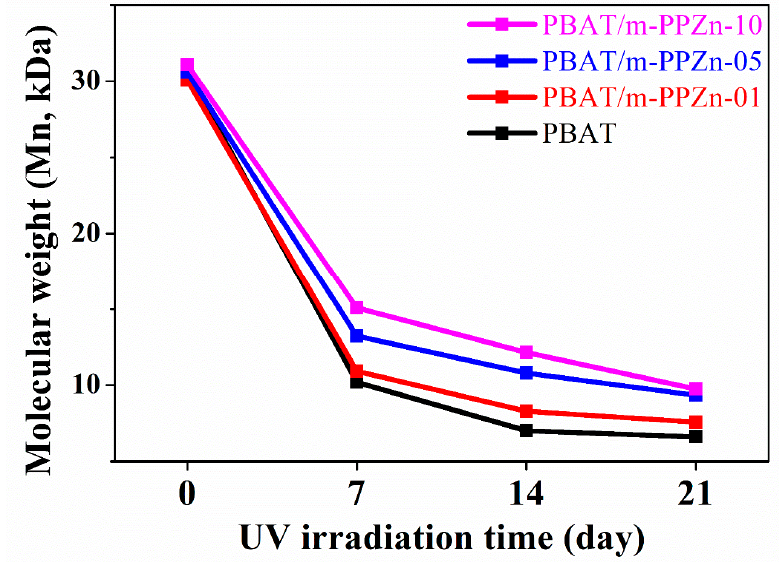
Figure 10. Average molecular weights ( M n ) of PBAT and the PBAT/m-PPZn composites after 21 days of UV irradiation.